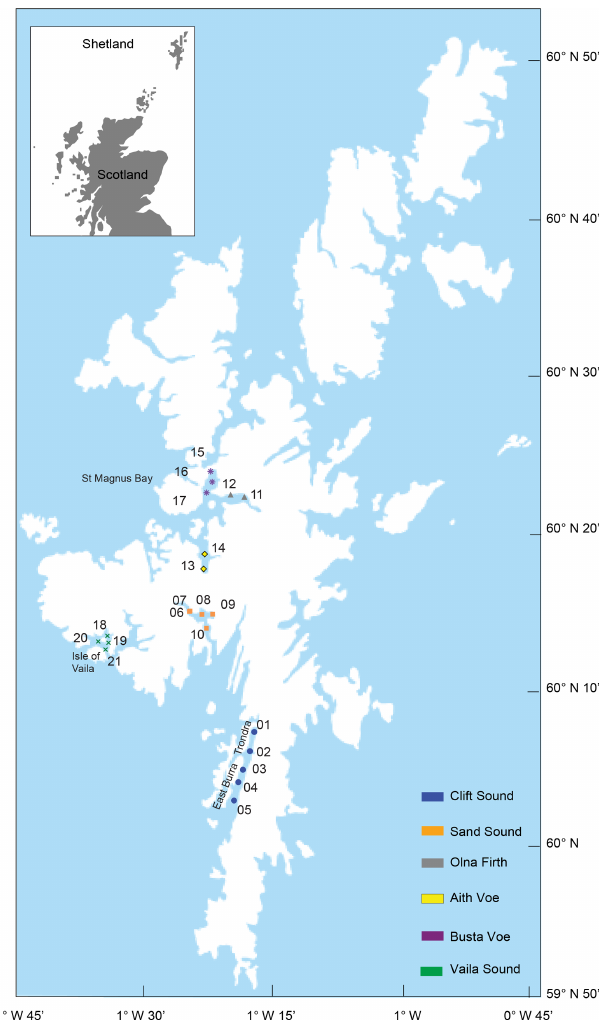
Figure 1. Location map of Shetland and the sampling